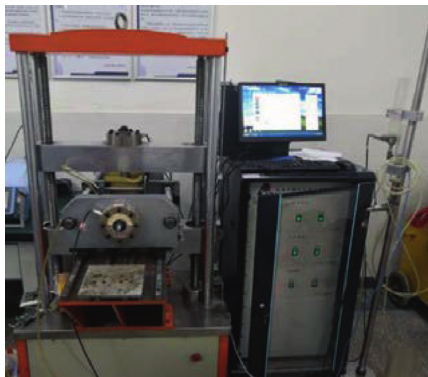
Figure 2: TSW-50 soil true triaxial testing machine.